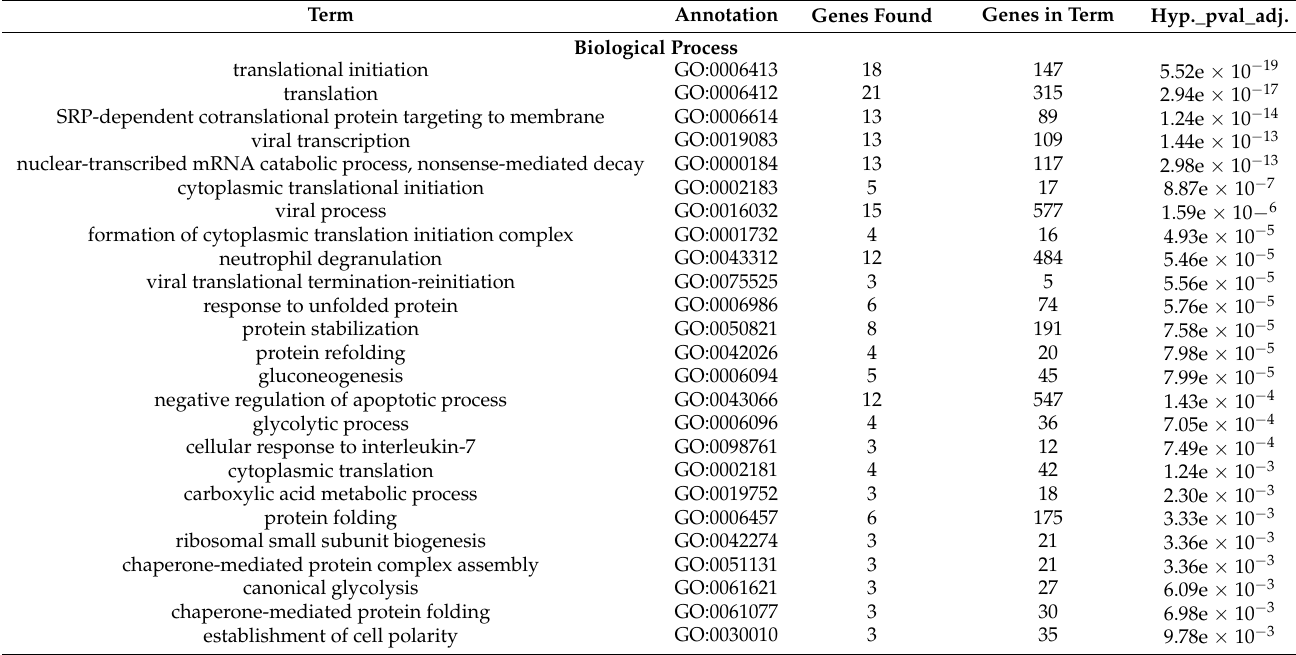
Table 1. Gene ontology term over-representation analysis. eIF3A-interacting proteins were analyzed on the genecodis webpage for overrepresentation of GO-terms in biological processes, cellular components and molecular functions. Only hits with an adjusted p -value less than 0.01 are